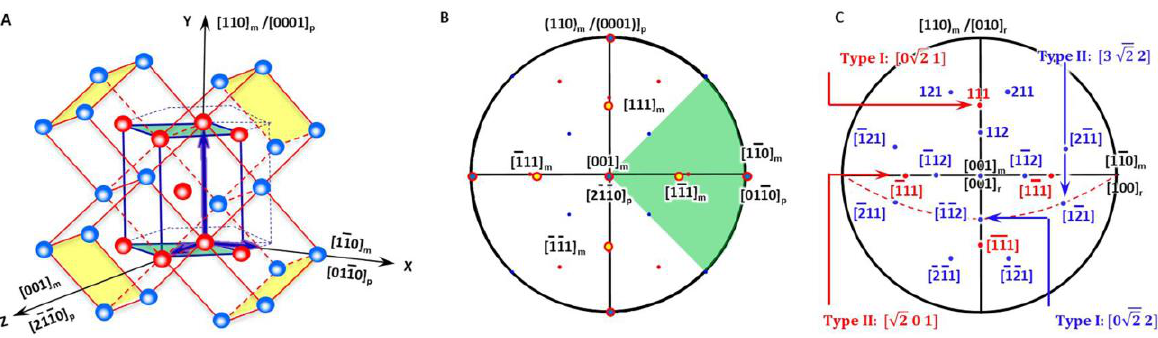
Figure 2. Lattice correspondence between HCP and BCC structures. ( A ) 3D atomic model. ( B ) Stereographic projection showing initial P-S OR describing lattice correspondence. ( C ) Burgers vector and shear plane variants in reference coordination system.